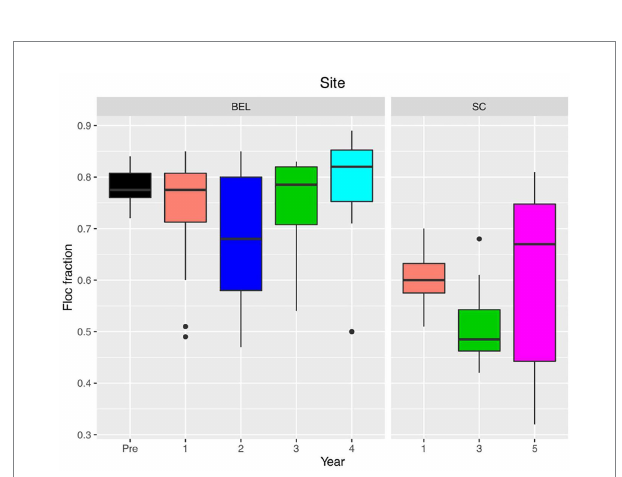
FIGURE 8 Floc fraction for sediment samples over time at BEL and SC restoration